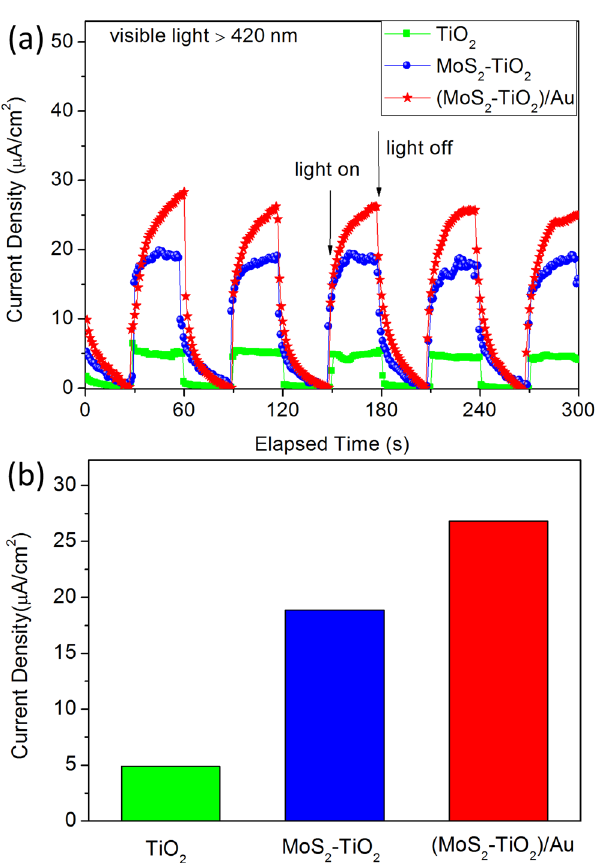
Figure 5. Photocurrent responses of TiO 2 , MoS 2 -TiO 2 , (MoS 2 -TiO 2 )/Au electrodes recorded in 0.1 M Na 2 SO 3 and Na 2 S aqueous solution under visible light by light-on and light-off